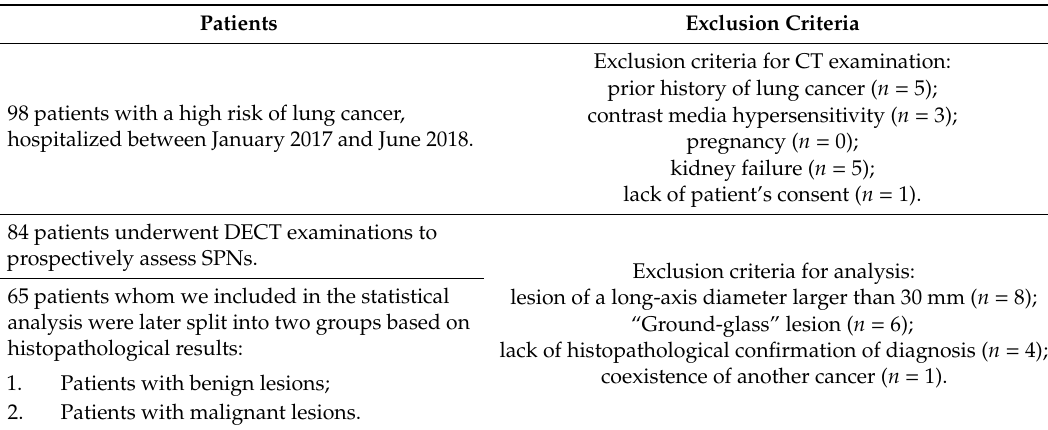
Table 1. Inclusion and exclusion criteria.